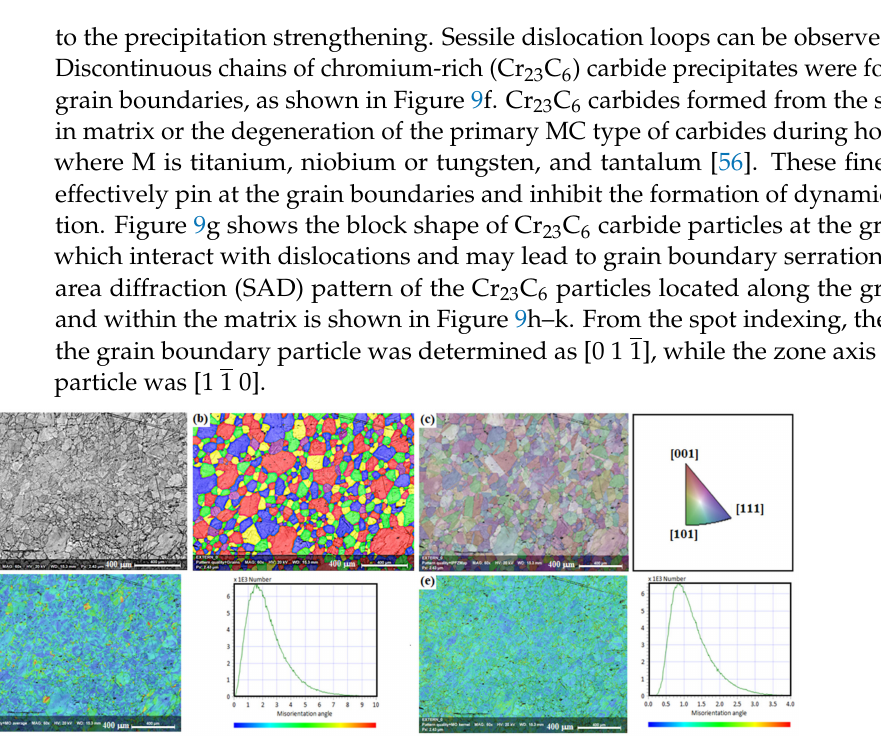
Figure 8. EBSD analysis on the heat-treated sample at 1200 ◦ C underwent a creep test at 800 ◦ C under 100 MPa stresses; ( a ) pattern quality (PQ) map, ( b ) pattern quality grains map, ( c ) inverse pole figure (IPF) map, ( d ) grain average misorienta- tion (GAM) map and ( e ) kernel average misorientation (KAM) map.